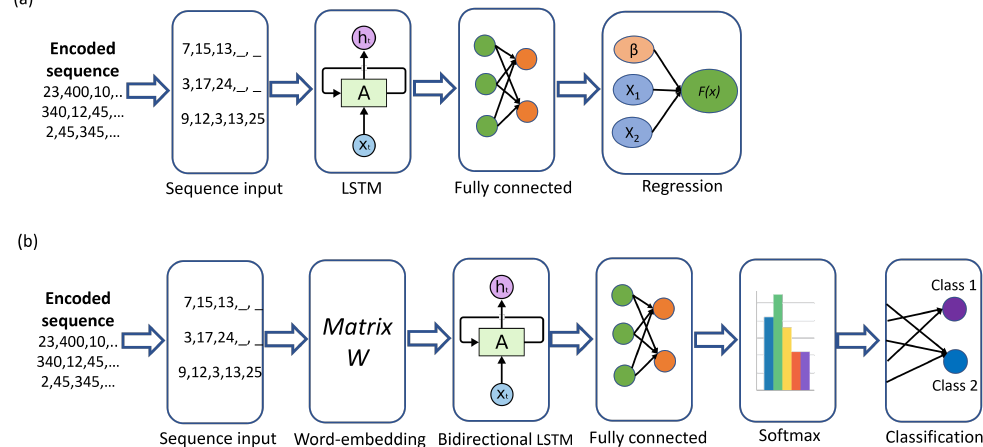
Figure 2. ( a ) LSTM Network architecture for AURC regression. ( b ) Biderectional LSTM Network architecture for generating protein